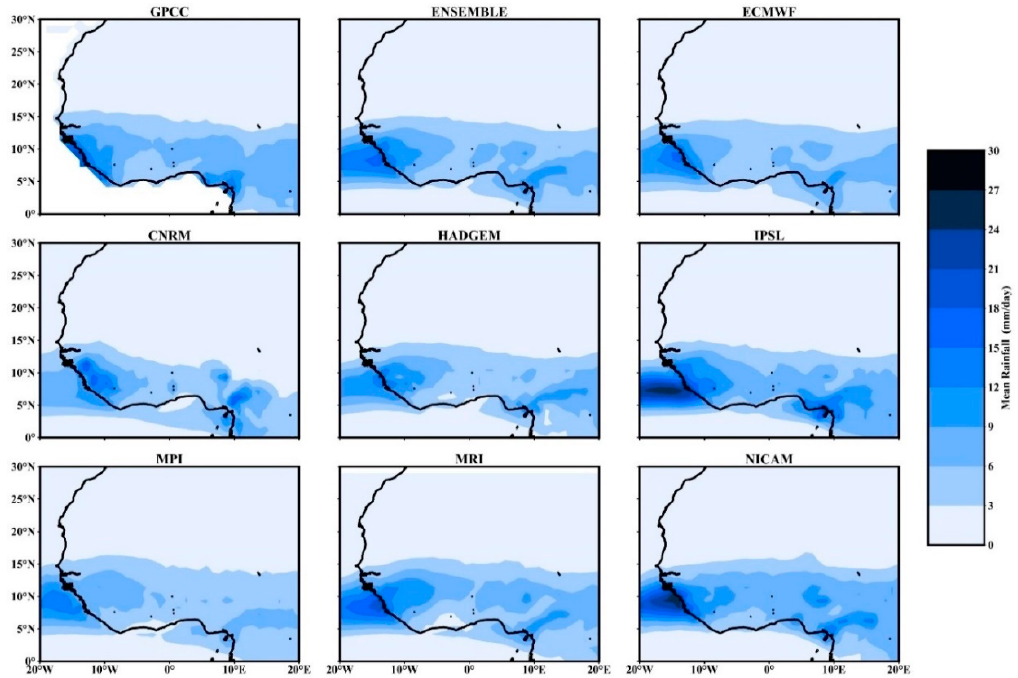
Figure 3. Comparison of GCM simulation of daily climatology of precipitation (mm/day) from June to September with respect to Global Precipitation Climatology Centre (GPCC) data over West Africa. Atmosphere 2020 , 11 , x FOR PEER REVIEW